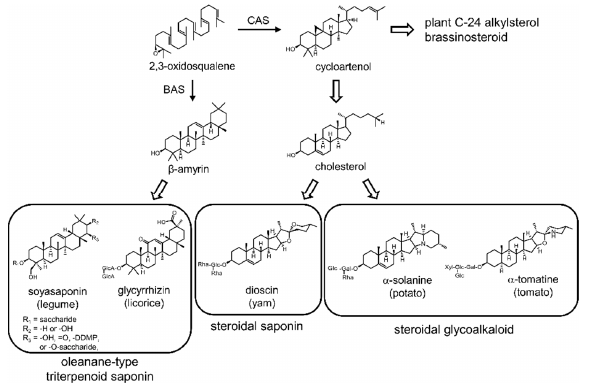
Figure 1. Chemical structures and biosynthesis of the plant saponins tested in this study: BAS, β‐ amyrin synthase; CAS, cycloartenol synthase.